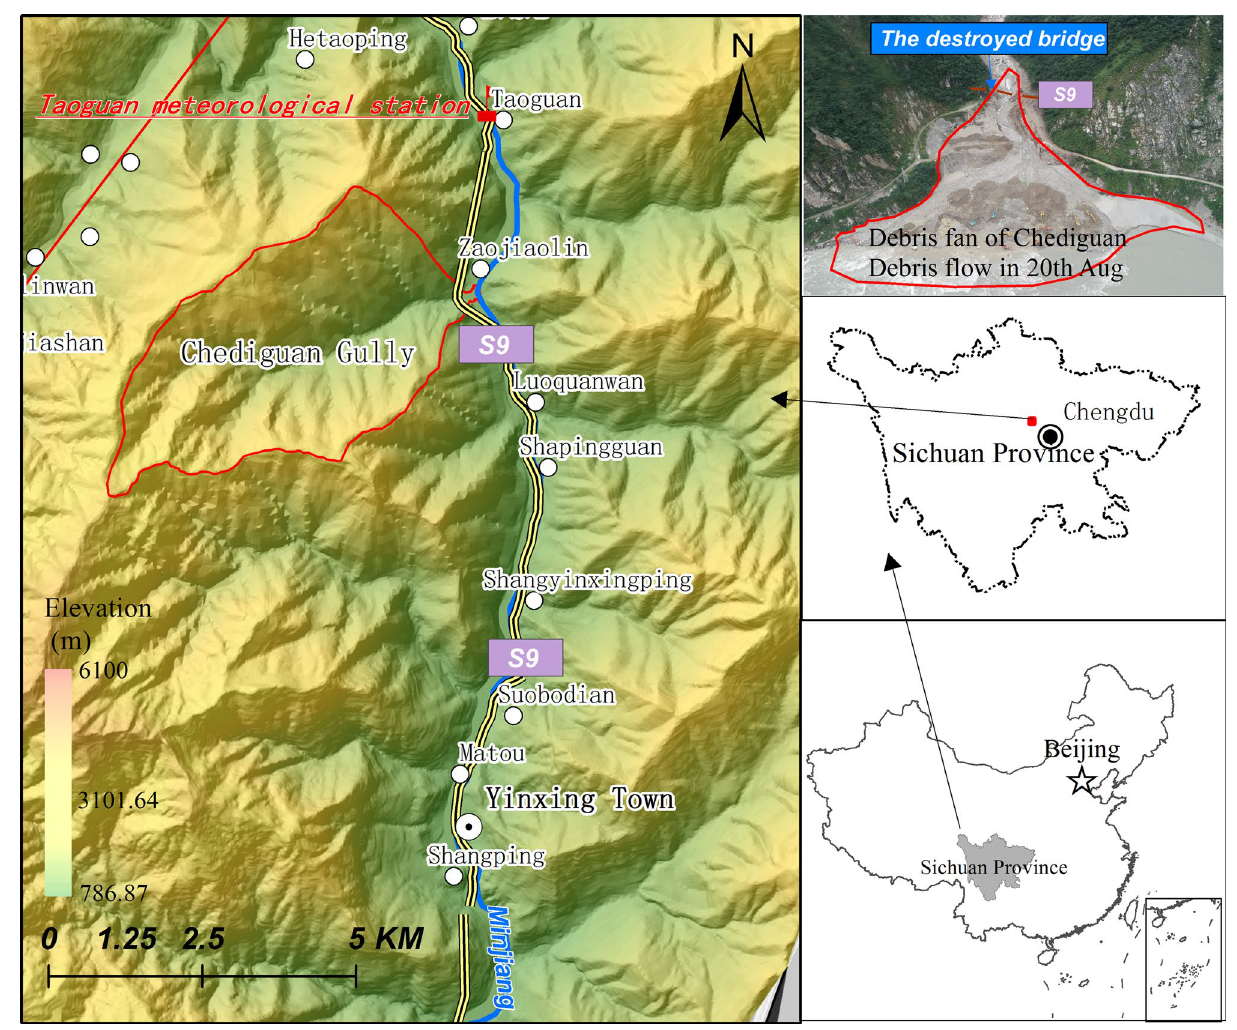
Figure 2. Location map of the study area. Maps constructed using ArcGIS 10.2 (https:// deskt op. arcgis. com/ the ditch and abundant reserves of original provenance. According to a survey, the total amount of loose source materials in 2011 reached 742.679 × 10 4 m 3 , and the reserves were 194.525 × 10 4 m 3 in volume 9 . The abundant source material provides favorable conditions for debris flows. The study area is located in a subtropical humid climate zone and is a concentrated area of heavy rainfall in the Minjiang River Basin. The average annual rainfall in this area is 1253.1 mm, the maximum annual rainfall is 1688 mm, and the minimum annual rainfall is 836.7 mm. The maximum continuous rainfall for 4 months (June–September) is 853.2 mm, comprising 68.2% of the annual rainfall. The rainfall in the survey area is abun- dant and concentrated and can meet the hydrodynamic conditions required to stimulate debris flows. Debris flows broke out several times in Chediguan gully after the “5.12” earthquake (Fig. 1 and Table 1). According to the investigation and interview, this gully belongs to an old debris flow gully, and there have been four mudslides in recorded history (Table 1). One mudslide occurred in the year 1952 10 , but its scale and the damage caused by it have remained unascertained for a long time. The second mudslide occurred on the evening of August 13, 2010 11 . When the accumulated rainfall reached 102.8 mm and the hourly rain intensity reached 14.2 mm/h, debris flows broke out in the tributaries on both sides of the gully, but no debris flow occurred in the main channel. The third mudslide occurred on July 3, 2011. Affected by heavy rain, a debris flow comprising approximately 1.5 × 10 4 m 3 of material was washed down from upstream and accumulated in the downstream main channel, destroying the drainage canal on the upper side of the Ying-Wen Highway and some mechanical equipment. The fourth mudslide occurred on July 20, 2011. Heavy rainfall caused a large-scale debris flow in the early morning. The total amount of rushing material reached 10 × 10 4 m 3 , causing the lateral displacement of the G213 bridge offset by 12 cm and interrupting traffic for 2 d. At the same time, more than 1/3 of the Minjiang River was blocked by debris.